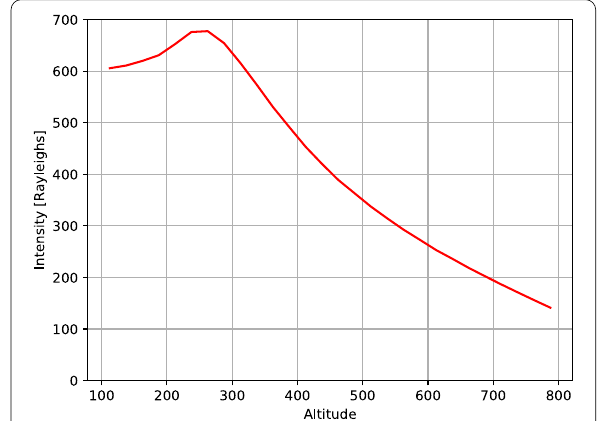
Fig. 10 Simulated altitudinal profile of the EUV photon flux (in Rayleighs) where the tangent point of the line of sight was set at 40 ◦ in latitude and 0722 LT on 6